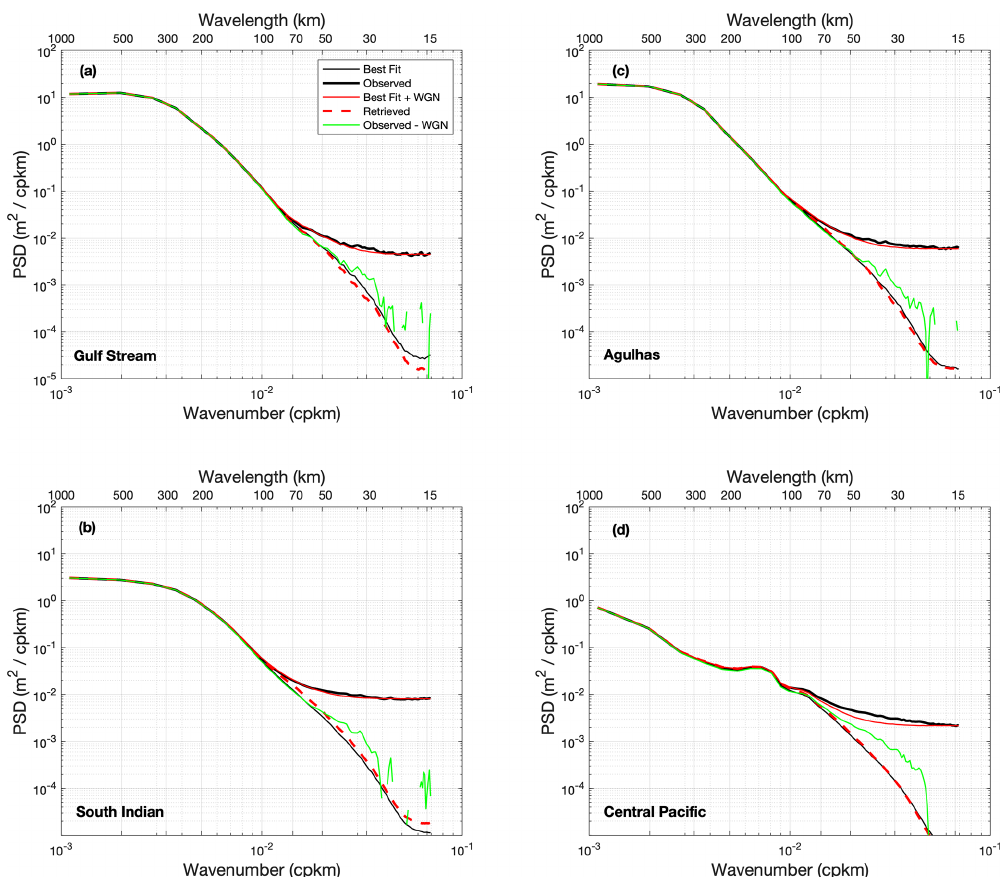
Figure 4. Mean PSD of SARAL SLA along-track measurements: observed (thick black), best fit (thin black), best fit plus WGN (red), retrieved (dashed red), and observed minus WGN (green). WGN is estimated as the average in the range of 15–25km of the mean observed PSD (bold black curve). The PSD is the average of PSDs computed over all data segments covering the years 2016–2018: the Gulf Stream (72–60 ◦ W, 44–32 ◦ N, a ), the South Indian (80–110 ◦ E, 60–40 ◦ S, b ), the Agulhas (10–35 ◦ E, 45–33 ◦ S, c ), the Central Pacific (170–150 ◦ W, 10 ◦ S–10 ◦ N, d )